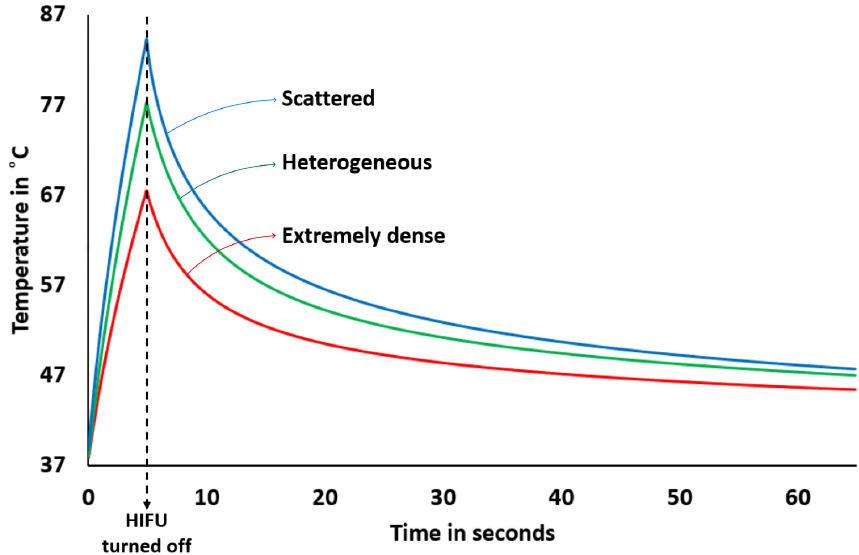
Figure 8. Variation of temperature at the focal point of HIFU with HIFU on-time (for 5 s) and off-time (for a minute). The starting temperature was 37 ◦ C.